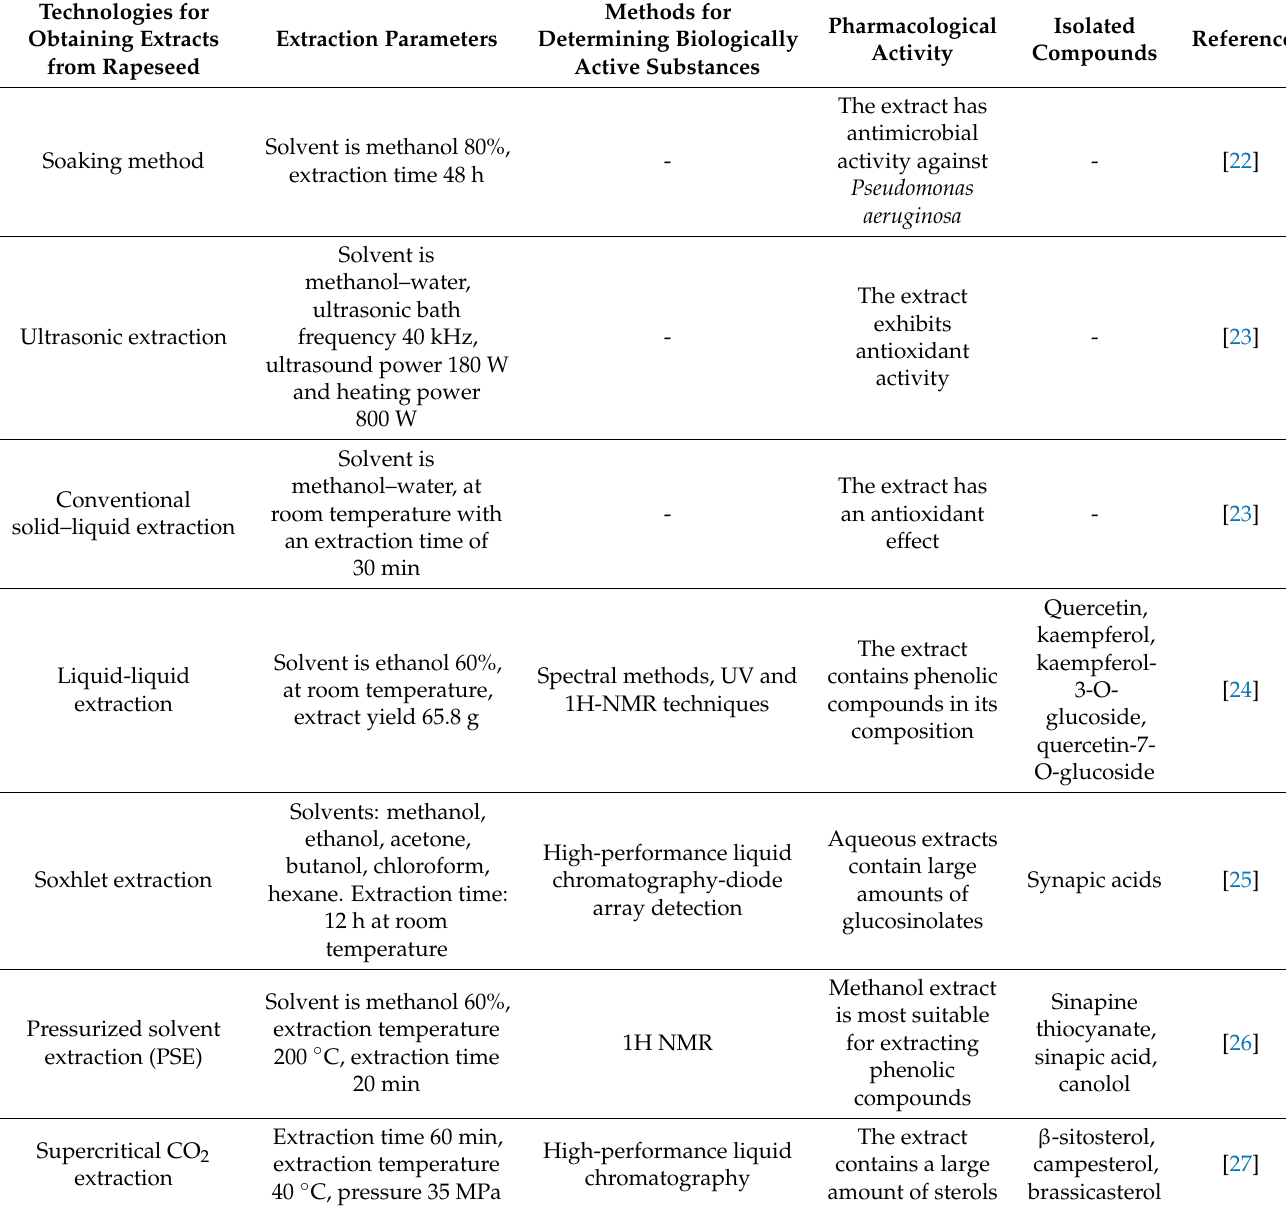
Table 1. Extracted biologically active compounds from rapeseed ( Brassica napus